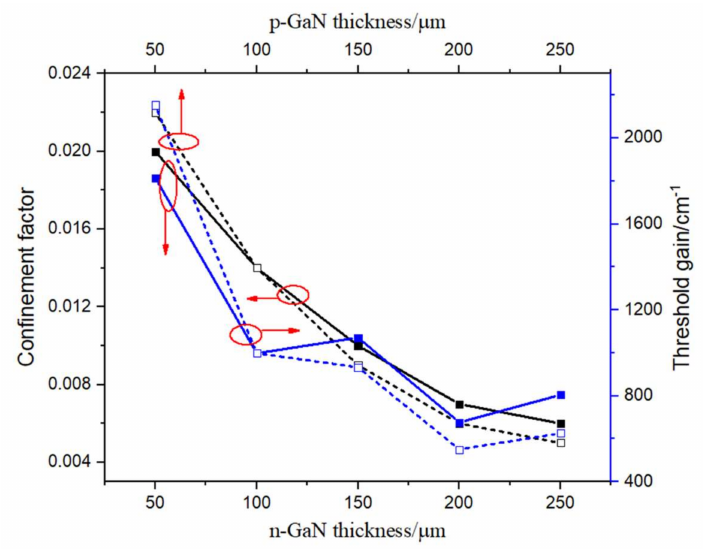
Figure 2. Confinement factor in PhCs and threshold gain plots as functions of n-GaN and p-GaN thickness, with holes depth 40 nm, lattice constant 194 nm, and hole radius 60